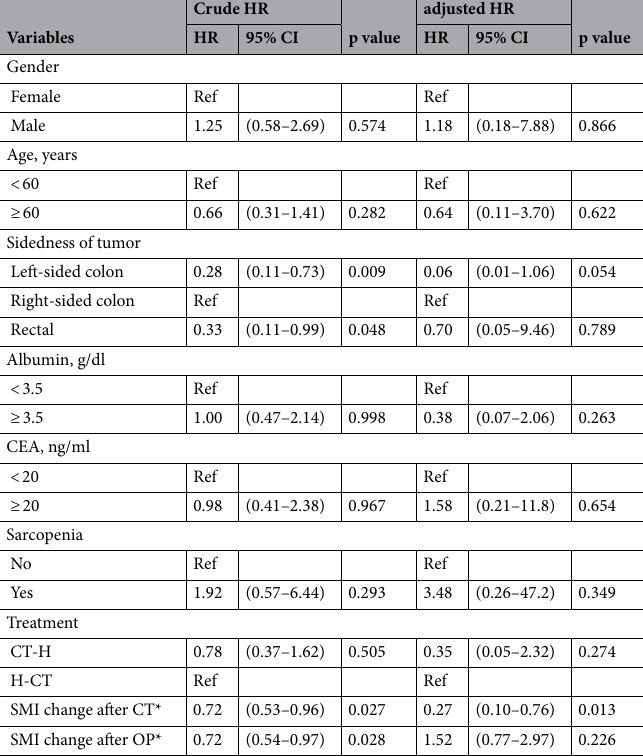
Table 2. Univariate and multivariate analysis of prognostic factors for overall survival. *HRs were calculated by per 10% increase of